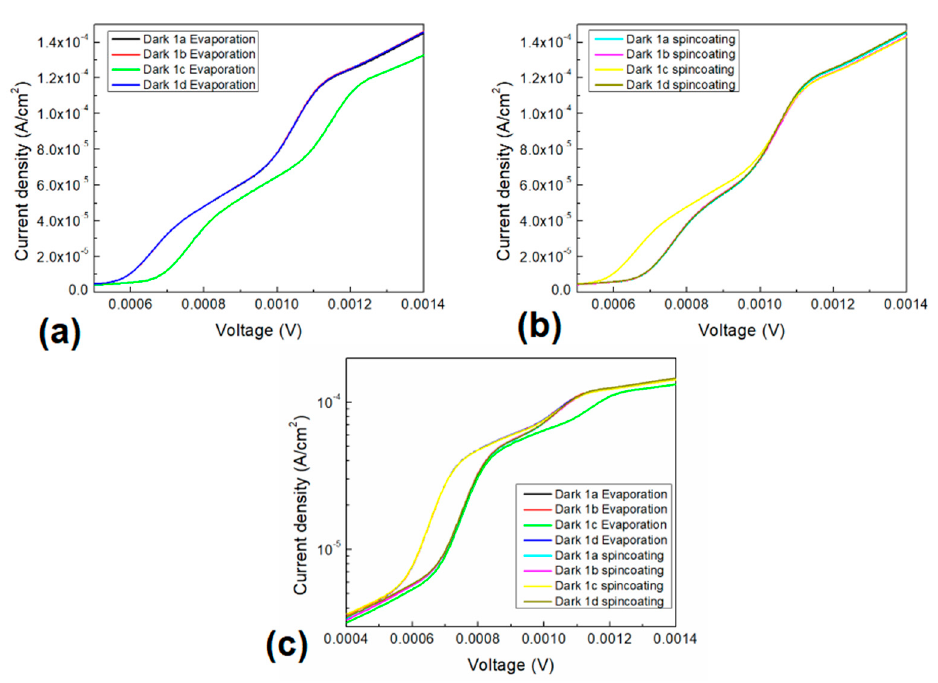
Figure 8. J-V characteristic for the ( a ) evaporated and ( b ) spin-coated and ( c ) semilogarithmic J-V characteristic for the organotin (IV) complexes devices.